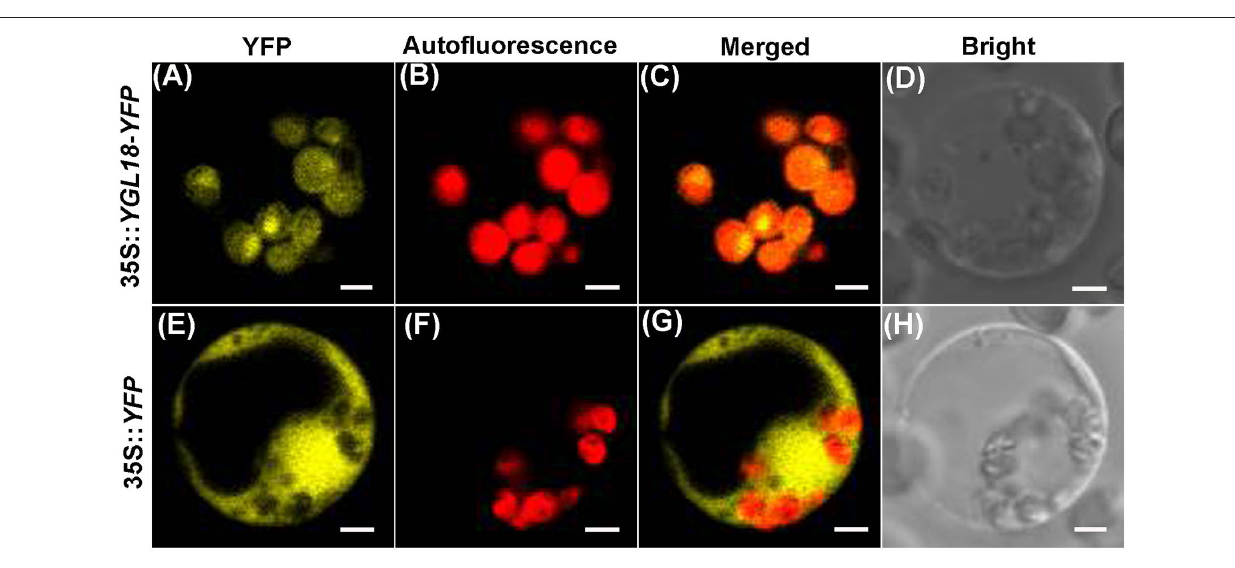
FIGURE 4 | Subcellular localization of YGL18 in rice. Rice protoplast transformed with: (A–D) 35S:: YGL18 - YFP , and (E–H) the empty vector 35S:: YFP as control. (A,E) YFP fluorescence images, (B,F) Chloroplast autofluorescence images, (C,G) Merged images of YFP fluorescence and chloroplast autofluorescence, (D,H) Bright field. Bar: 2 µ